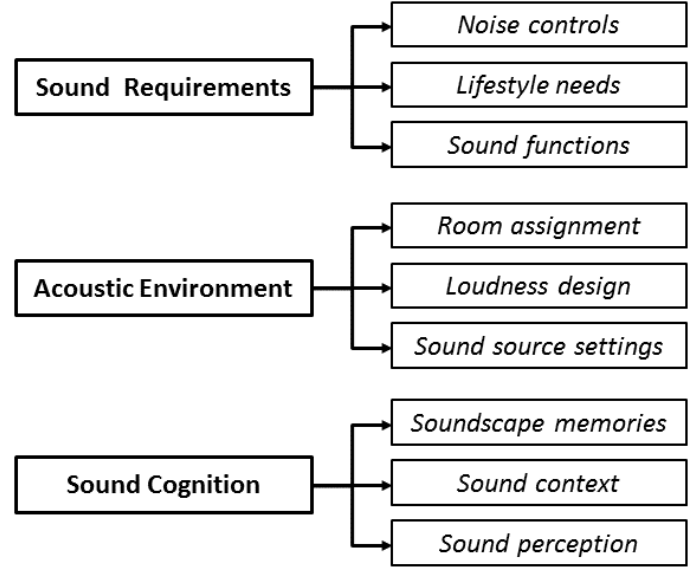
Figure 6. Sound perception model of the blind older adults in nursing homes.